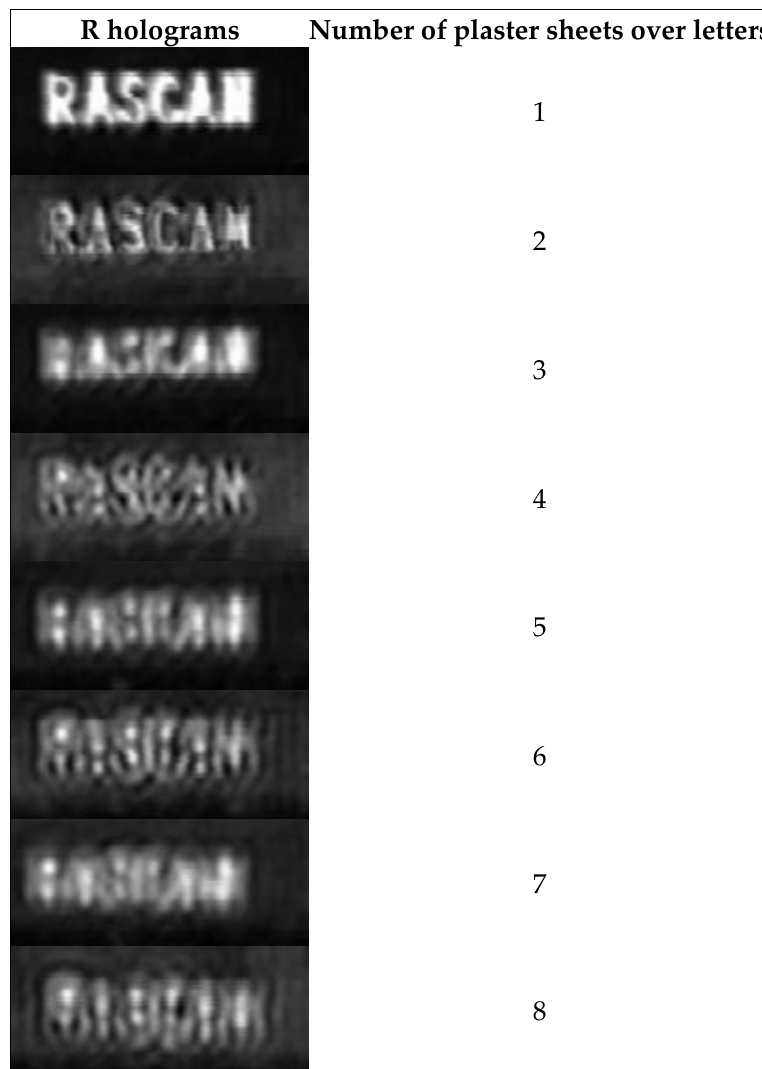
Figure 5. Paper sheet with aluminum foil letters (ruler is 12 inches, or 30.48 cm). R holograms